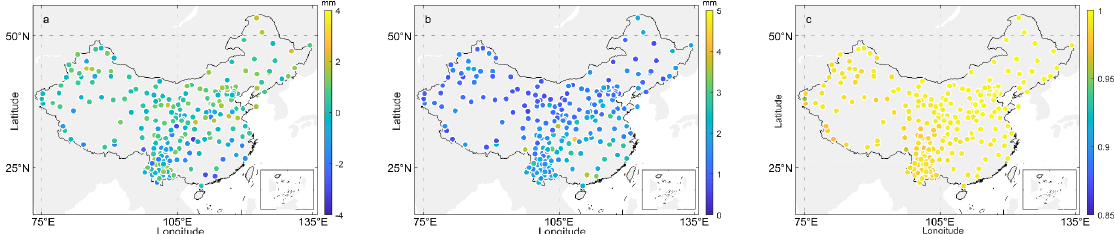
Figure 12. ( a ) Bias, ( b ) RMS, and ( c ) correlation coefficient between ERA-PWV and calibrated MOD-NIR-PWV in the six-year period studied over each grid point.